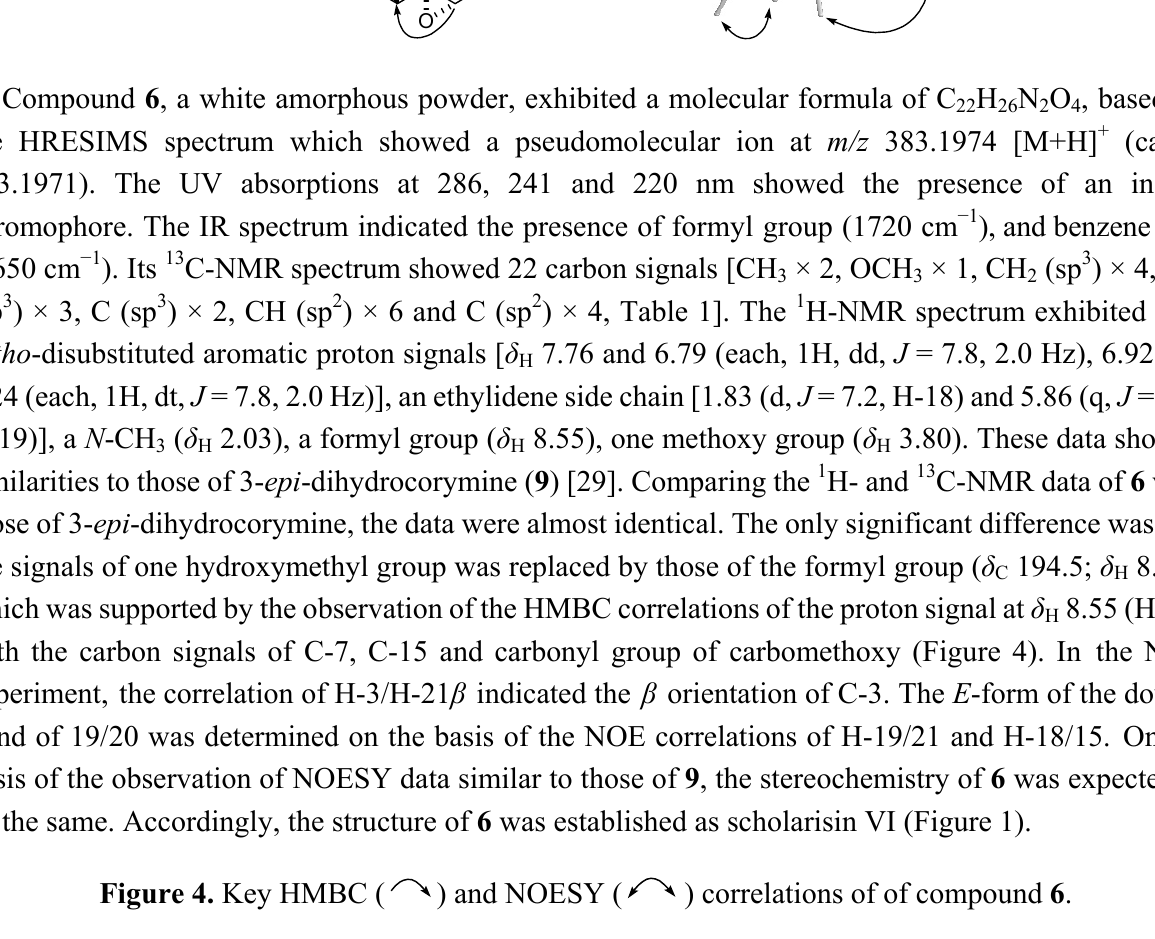
Figure 4. Key HMBC ( ) and NOESY ( ) correlations of of compound 6 .